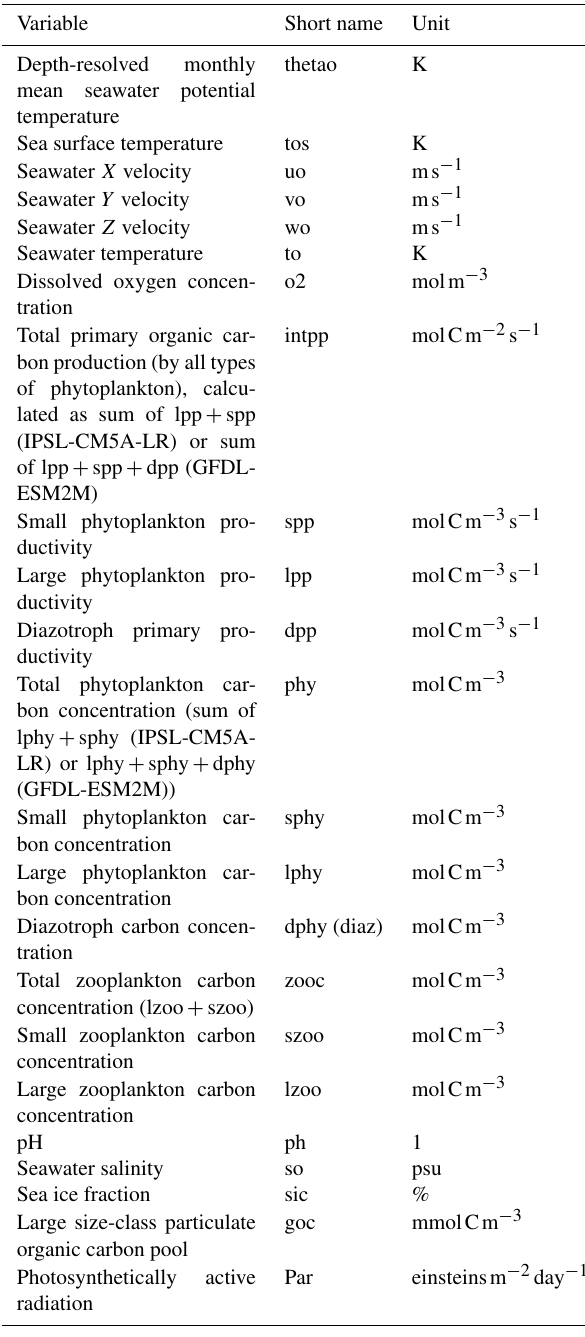
Table 3. Monthly oceanic data provided without bias adjustment for marine ecosystems & fisheries